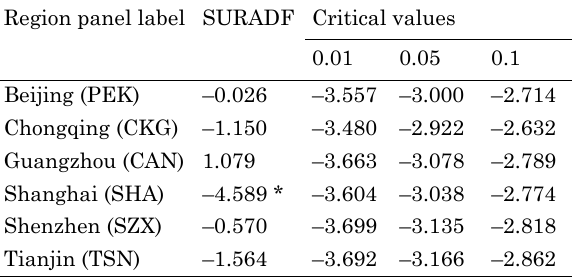
Table 3. Panel SURADF tests and critical values for regional house prices